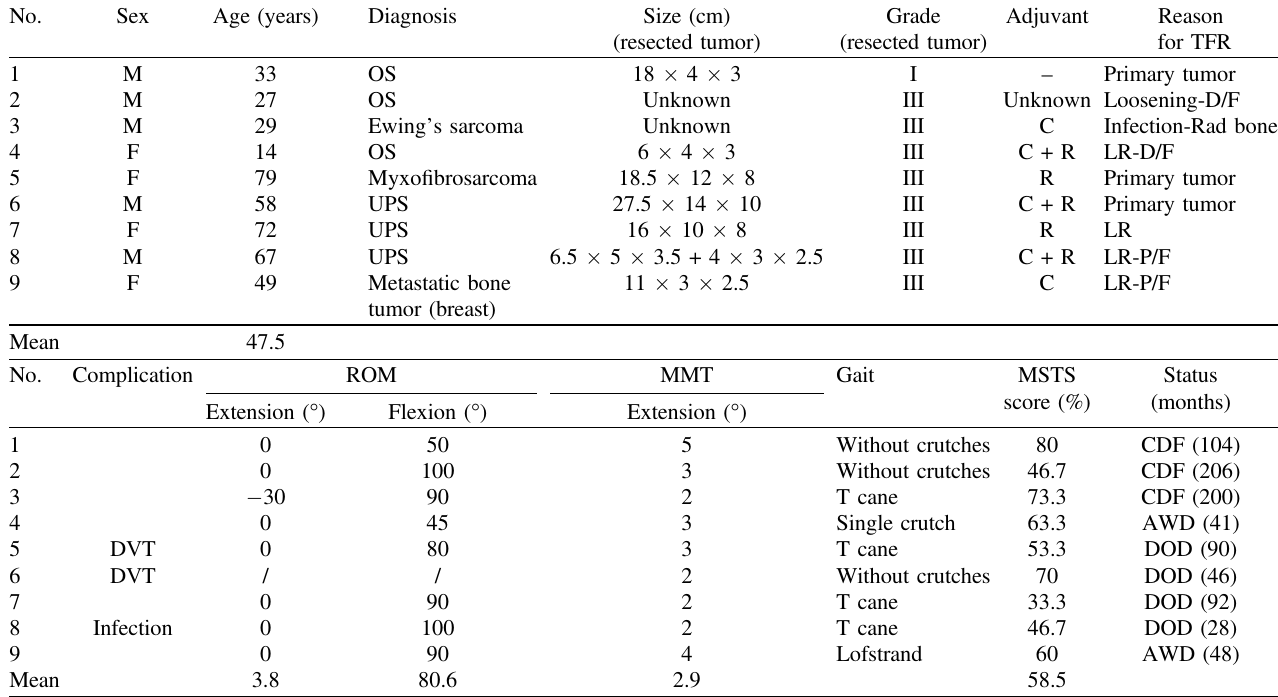
Table 1. Patient